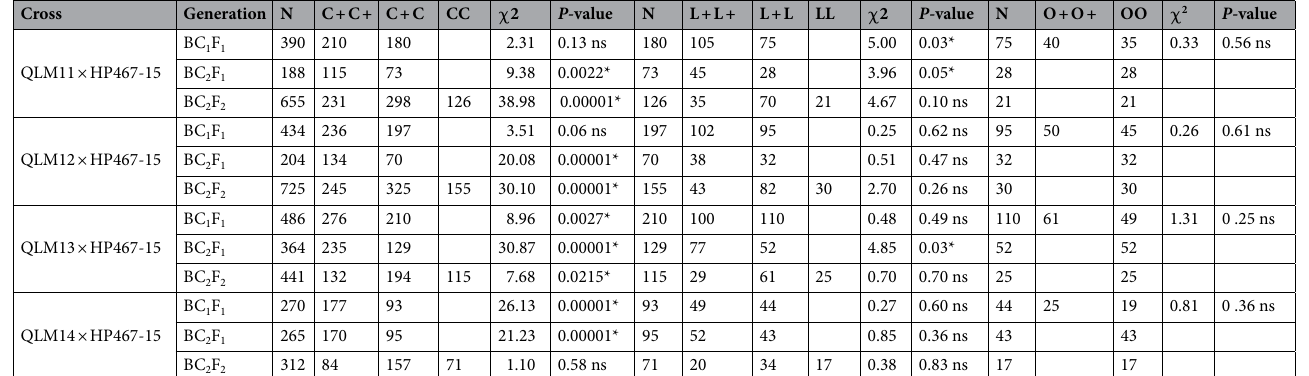
Table 1. Segregation pattern of crtRB1 3 ˊ TE, lcyE 5 ˊ TE and o2 alleles in different backcross and self- generations of the four crosses. *Significant at P = 0.05; ns, non-significant; N, No. of plants genotyped; df, degrees of freedom; C + , unfavorable allele of crtRB1 ; C, favorable allele of crtRB1 ; L + , unfavorable allele of lcyE ; L, favorable allele of lcyE ; O + , unfavorable allele of o2 ; O, favorable allele of o2 .